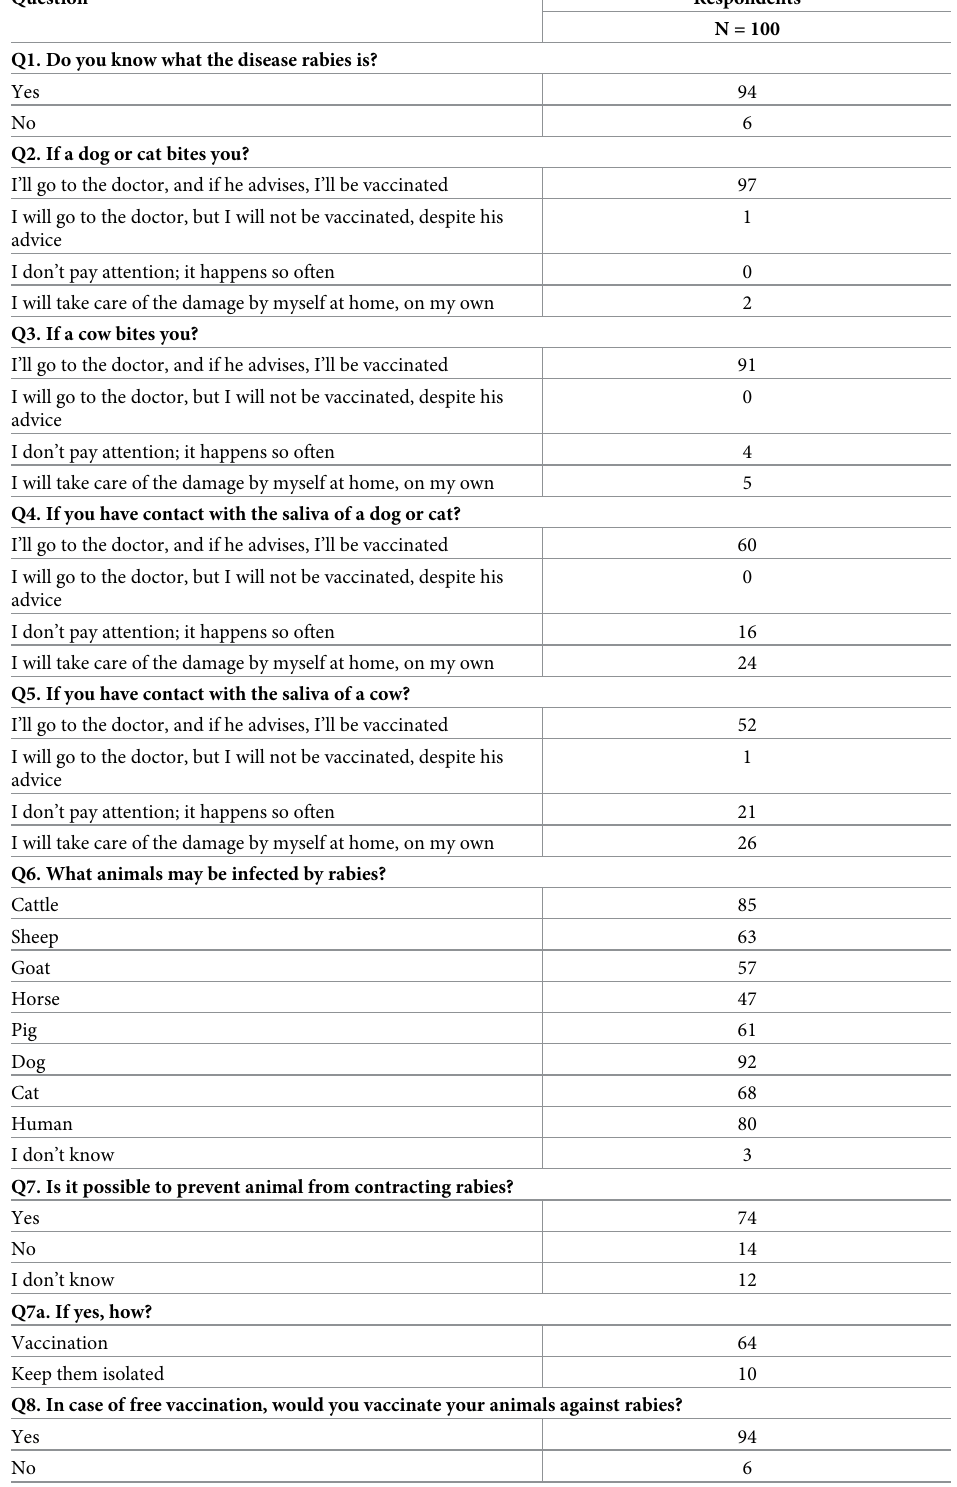
Table 3. Assessment of knowledge, attitudes, and practices of the respondents on rabies (N = 100). Question Respondents